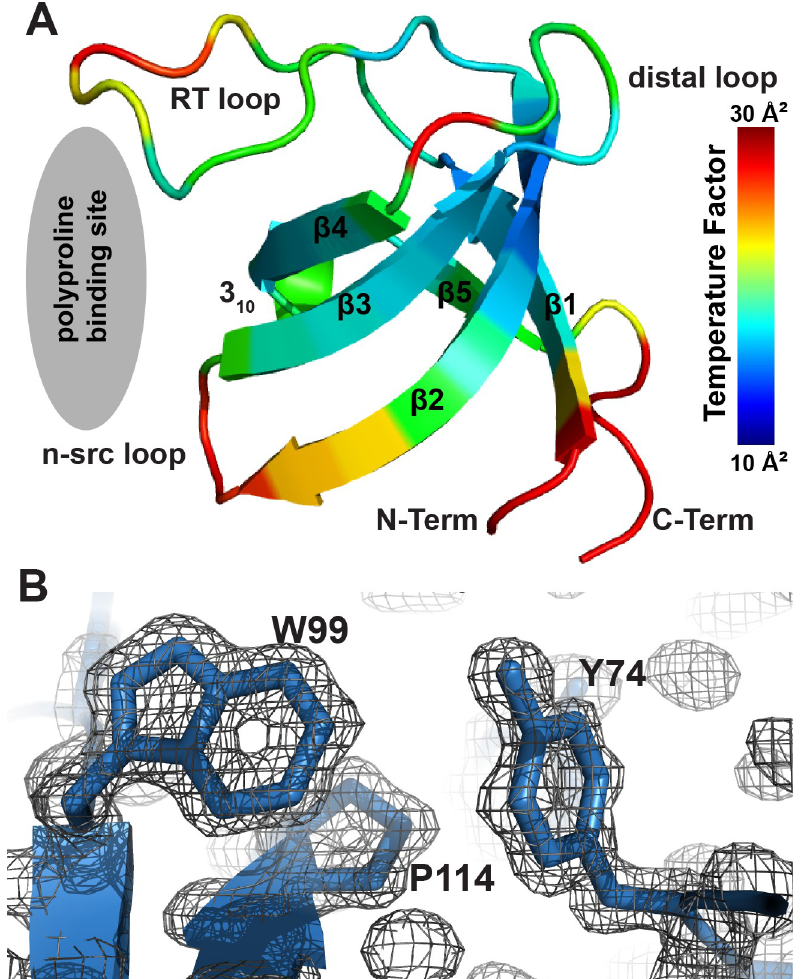
Fig 1. Crystal structure of the Lyn SH3 domain. A. Ribbons representation of the Lyn SH3 domain highlights the canonical β -barrel. The structure is colored by crystallographic temperature factor. B. 2 F contoured at 2.0 σ and rendered around Y74, W99 and P114. These residues contribute to the binding site for the polyproline motif [36] and are critical for protein-protein